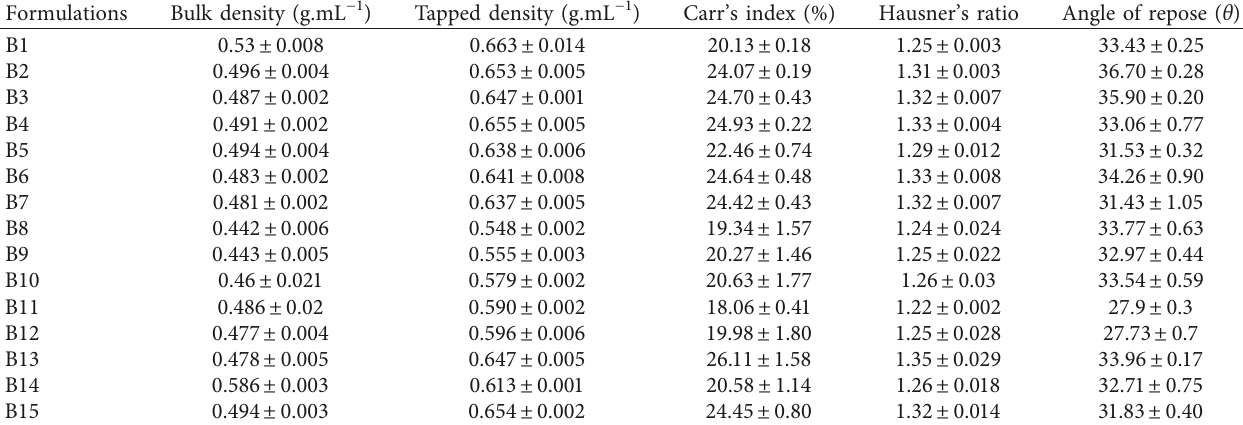
Table 5: Evaluation of precompression parameters of granules of fifteen different trial batches. Formulations